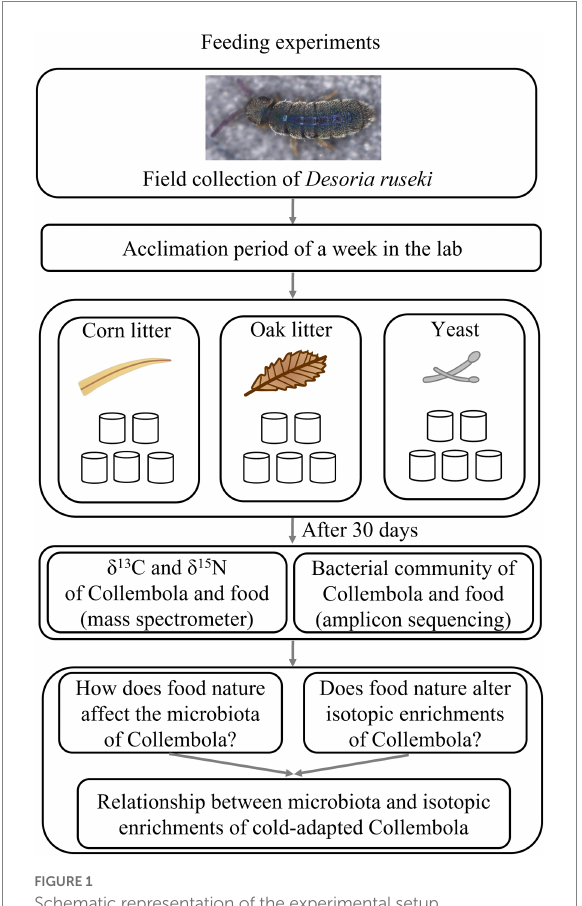
FIGURE 1 Schematic representation of the experimental